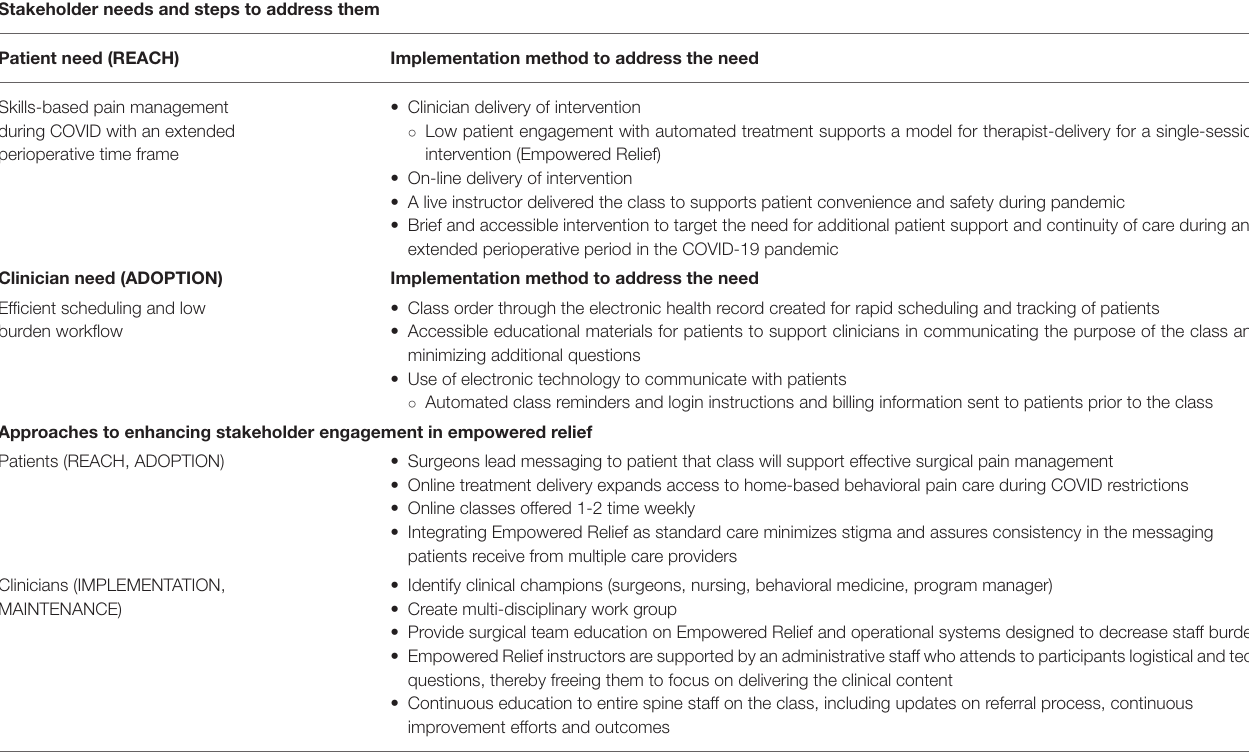
TABLE 1 | Stakeholder needs and engagement and alignment with RE-AIM dimensions. Stakeholder needs and steps to address